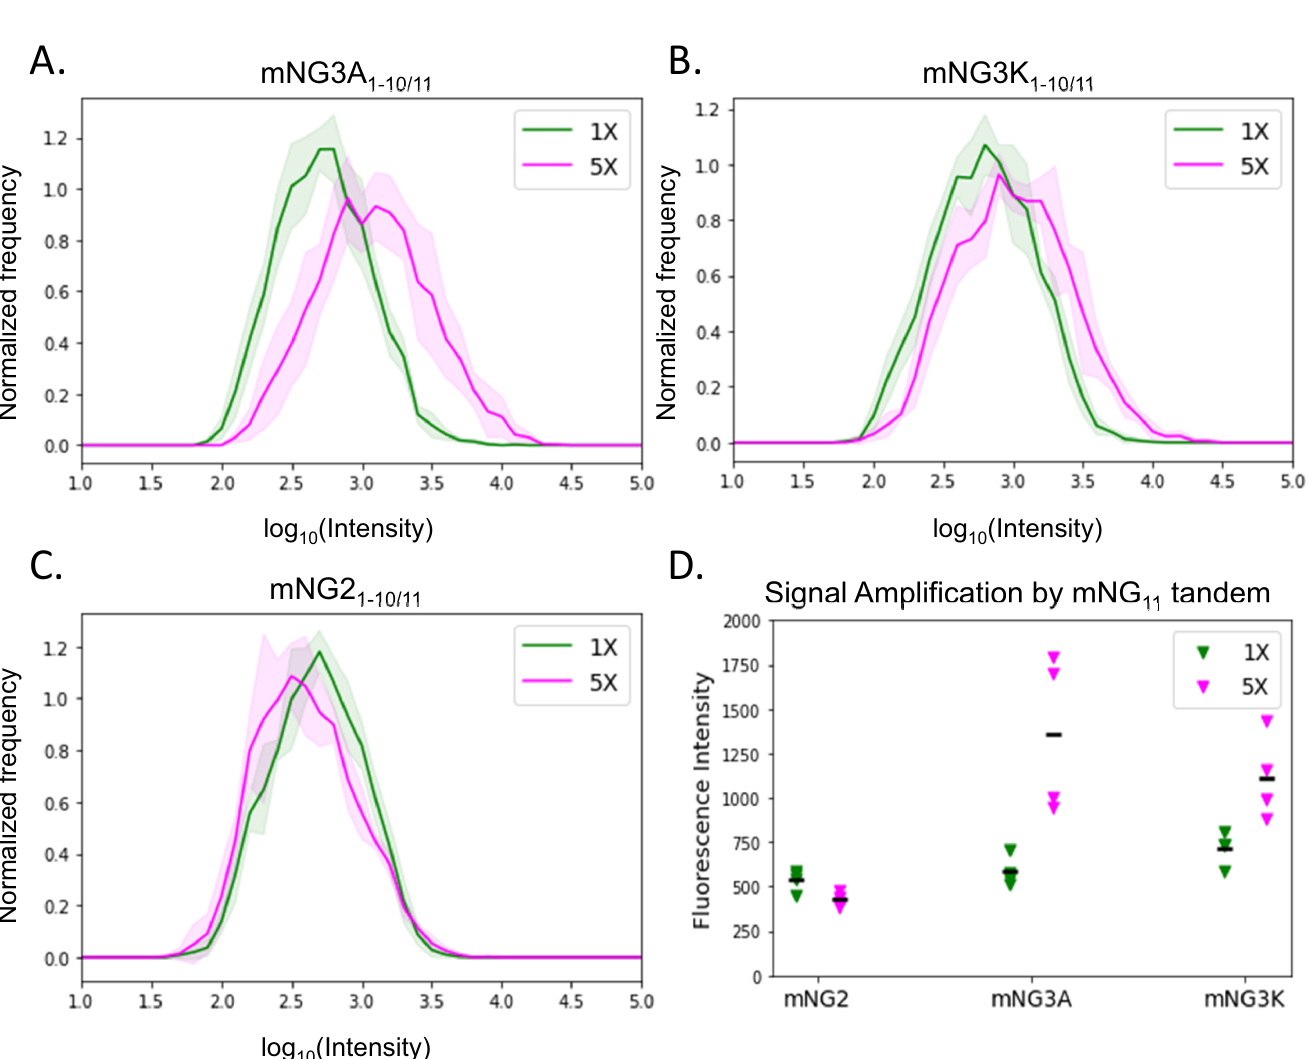
Fig 4. Significant signal amplification by tandem mNG2 11 with mNG3A 1-10 and mNG3K 1-10 . A-C. Fluorescence intensity distribution of individual cells transiently co-transfected with FP 11 (1x mNG2 11 in green or 5x mNG2 11 in pink) and FP 1-10 (mNG2 1-10 , mNG3A 1-10 or mNG3K 1-10 ), each condition has four replicates, solid lines show the mean of four distributions, the shadow indicates standard deviation. Representative images of the cells are shown in S4 and S5 Figs in S1 File. D. Each marker shows the median nuclear intensity for a field of view represented in A-C. Bars indicate the mean of all fields. Increased signal for mNG3A and mNG3K using 5x mNG2 11 is statistically significant (Welch’s